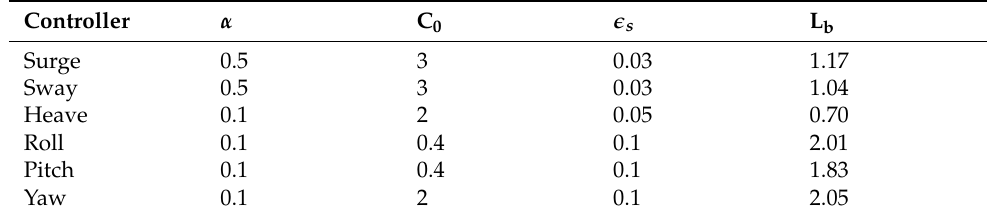
Table 6. Tuned control parameters for SMC.